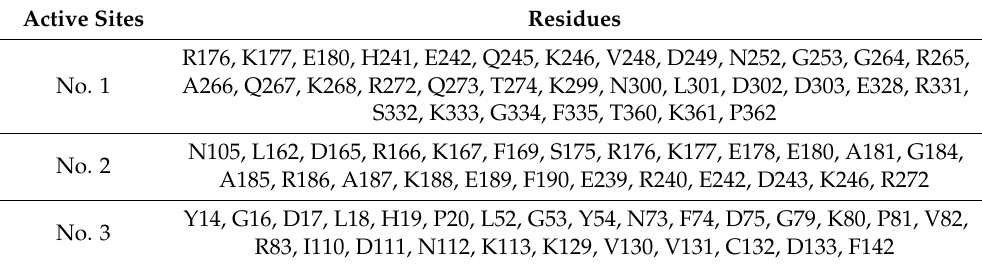
Figure 6. Influence of cancer-derived mutations over the PABPC1 structure. ( A ) Individual mutations from different cancer types (cBioPortal database [19]) represented over the PABPC1. Mutations with high frequency (>4; right panel) were further investigated via tracing stability changes (dStability) in the protein. RRMs are labeled according to their location: RRM1 (11–89 aa), RRM2 (99–175 aa), RRM3 (181–268 aa), and RRM4 (294–370 aa). ( B ) Change in stability for PABPC1 structure upon inserting point mutations. Residue scan module implemented in the MOE (Chemical Computing Group Inc., Montreal, QC, Canada) was implemented to trace the dStability (kcal/mol). The right panel represents the R331H/C mutations significantly reducing the protein stability. Table 1. Active site predicted over the PABPC1 modeled structure using the “Alpha Shapes” construc- tion geometric method [18] implemented in the MOE (Chemical Computing Group Inc., Montreal, QC, Canada)